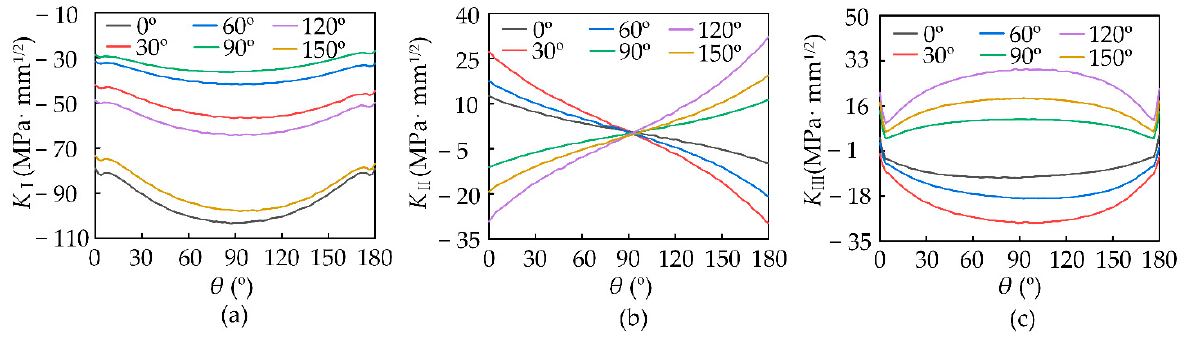
Figure 4. Distribution of the stress intensity factor (SIF) at different crack position angles: ( a ) K I , ( b ) K II , and ( c ) K III